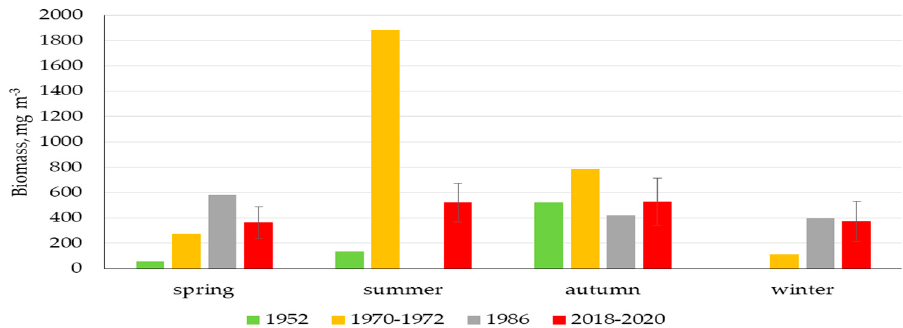
Figure 15. Long-term changes in the average ± SE biomass of phytoplankton (1952 and 1970–1972 according to [15], 1986 according to [8], 2018–2020 project data). according to [8], 2018–2020 project